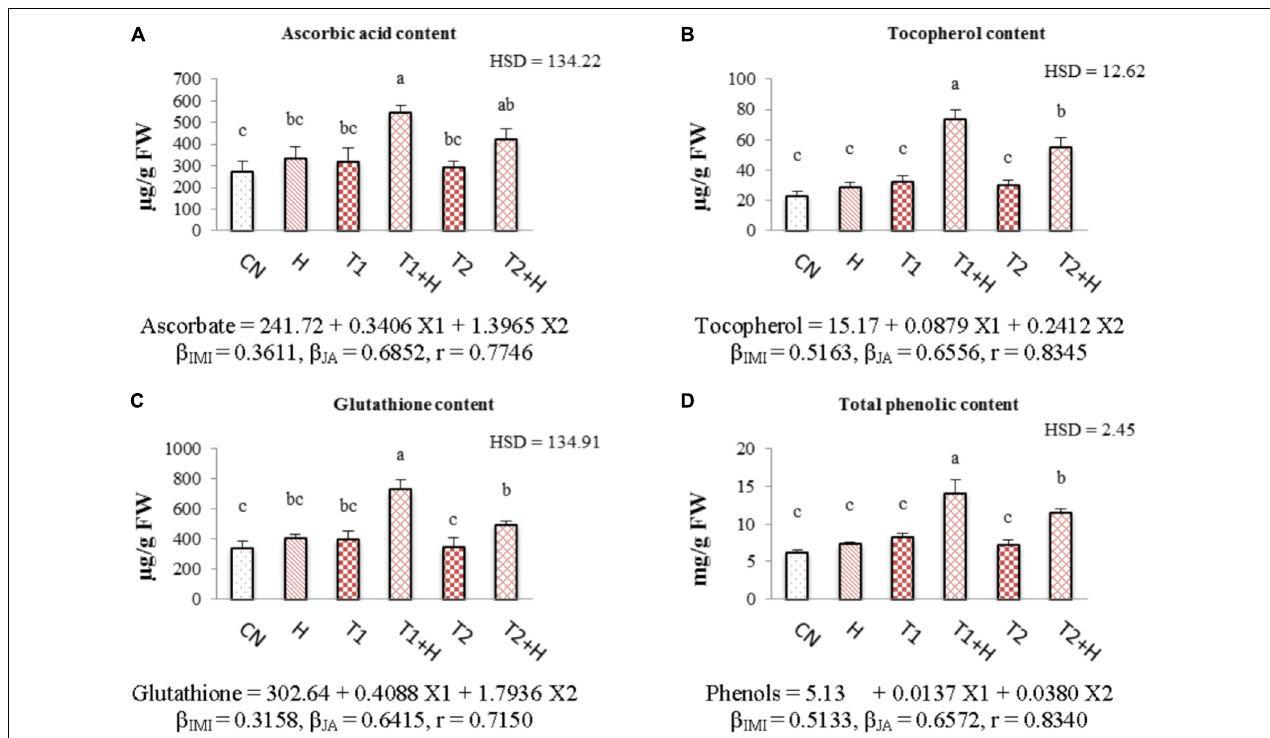
FIGURE 6 | Effect of JA seed soaking on the contents of non-enzymatic antioxidants in B. juncea seedlings under IMI stress. Data shown here are mean ± SD ( n = 3). Means with same letters are not significantly different from each other, IMI, imidacloprid (X1); JA, jasmonic acid (X2); T1, 200 mg · L − 1 (IMI); T2, 250 mg · L − 1 (IMI); H, 100 nM (JA); r, multiple correlation coefficient. β = β -regression coefficient. A = ascorbic acid; B = tocopherol; C = glutathione; D = total